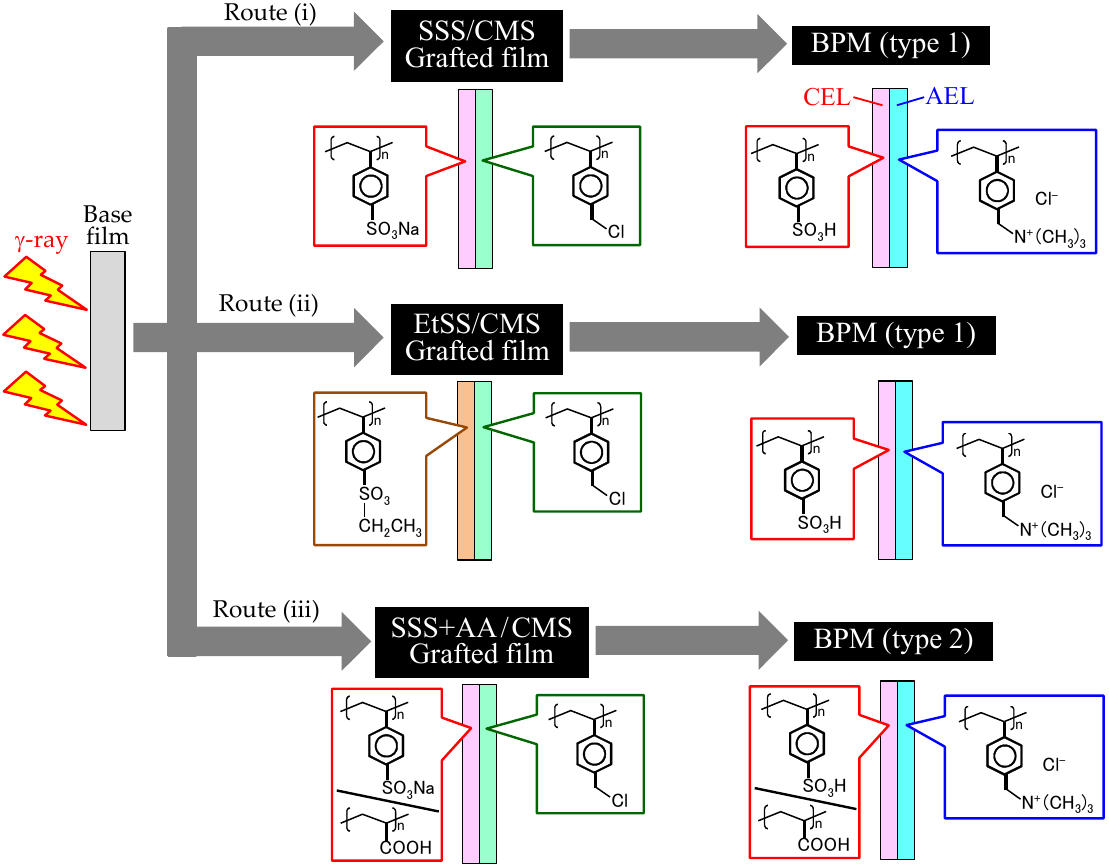
Figure 2. Three potential routes (i)–(iii) for the preparation of bipolar membranes (BPMs) by RIAGP.